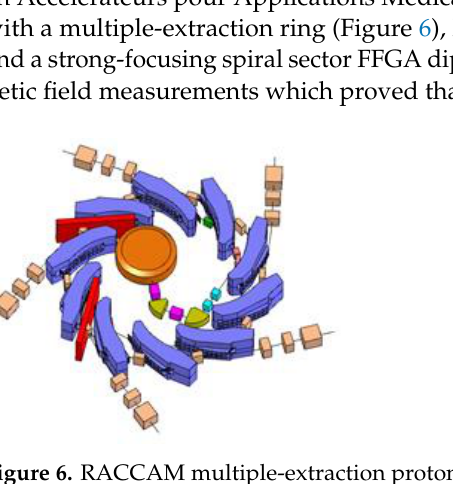
Figure 6. RACCAM multiple-extraction proton therapy FFGA ring. Reproduced with permission from Ref. [50].